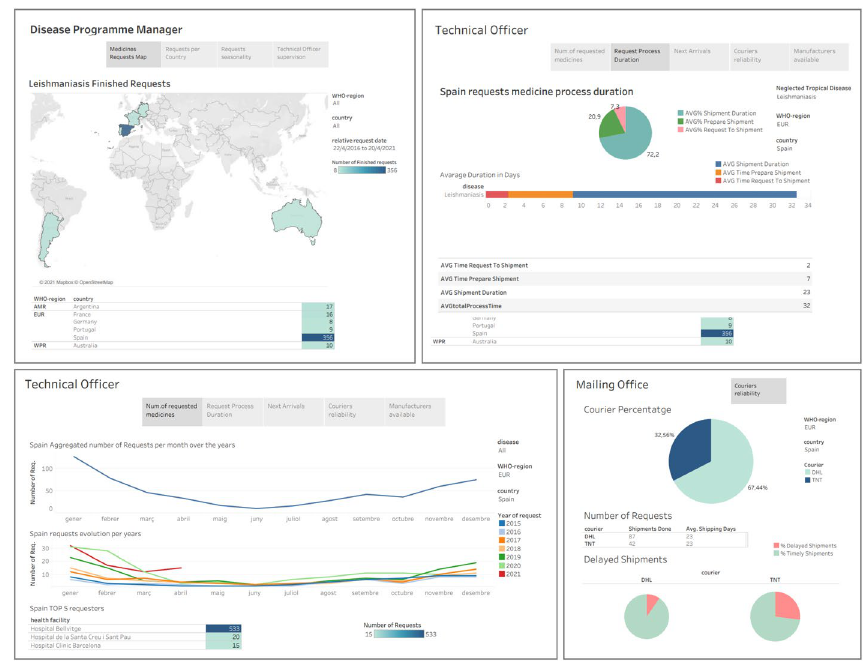
Fig. 7 Example of the medicine request dashboards in the Exploitation